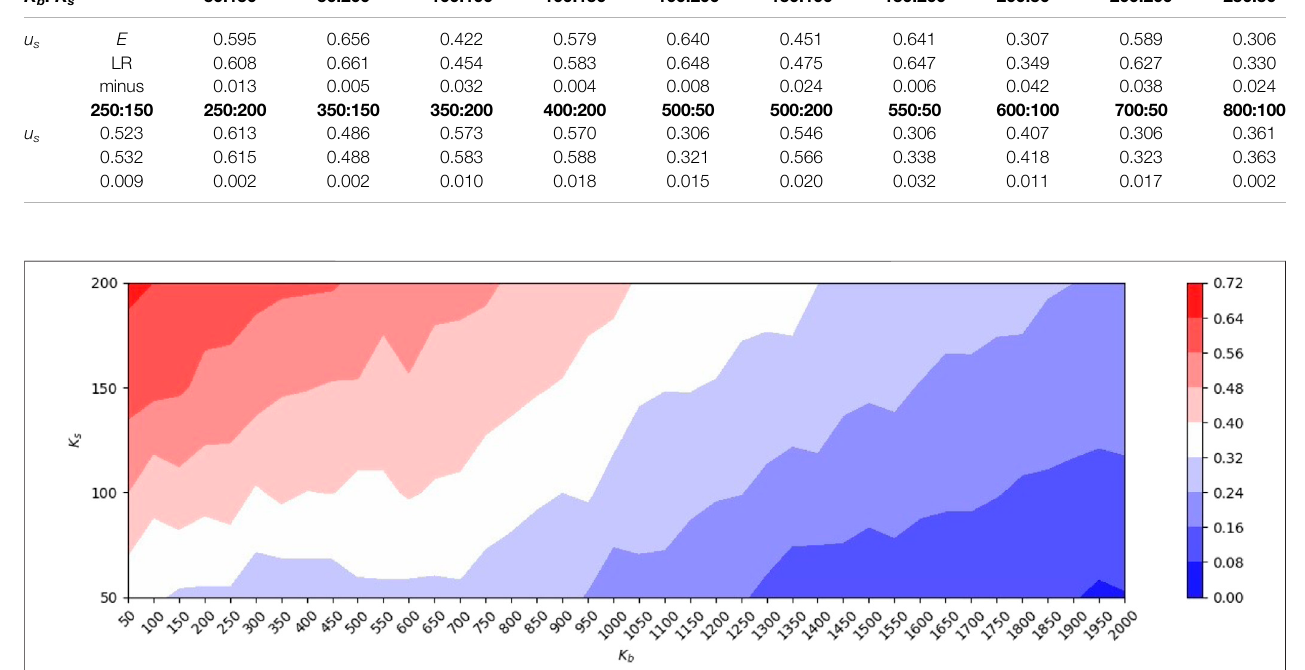
FIGURE9 | Contourplots ofequilibrium utility values with thenumber ofblocker ’ s and spreader ’ s seed nodes K b , K s on realonline social networkfrom Facebook.